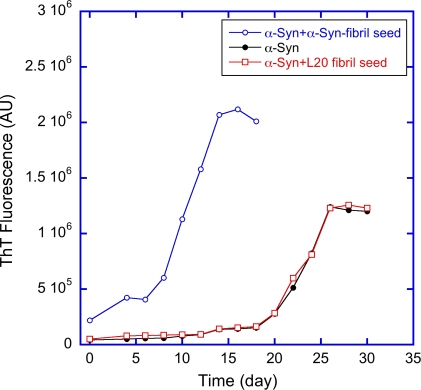
Lack of Seeding Capacity of L20 Fibrils on α-SynThe freshly prepared α-Syn solution in PBS (pH 7.4) was incubated with 5% (v/v) seed of matured L20 amyloid in 5% D-mannitol at 37 °C with vigorous stirring. α-Syn in PBS (pH 7.4) with 5% (v/v) of 5% D-mannitol was also incubated as a control. The formation of amyloid was monitored for the mixture (α-Syn+L20; red line), α-Syn in the presence (positive control; blue line) and the absence (negative control; black line) of α-Syn seed (5%) by Thio T binding. The intensity of Thio T fluorescence is shown as arbitrary units (AU) versus time.